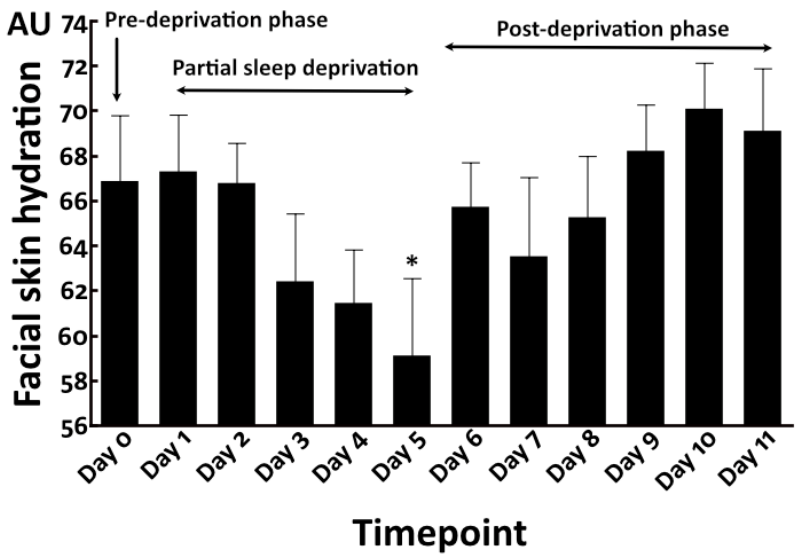
Figure 8. Facial skin hydration in repeated partial sleep deprivation study. *: p < 0.05 compared to Day 0.